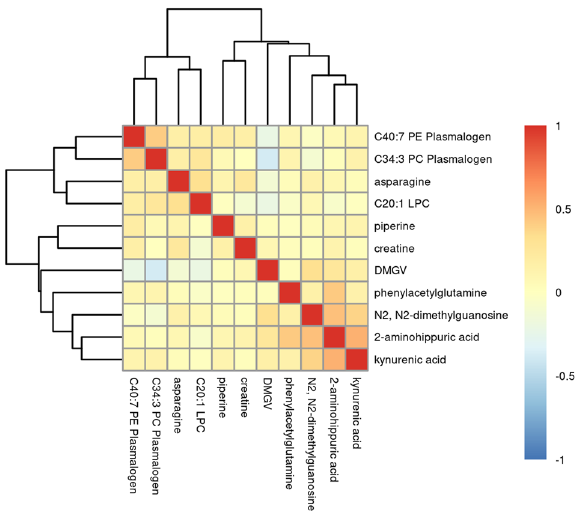
Fig. 2 Heatmap of all pairwise correlations among the 11 metabolites associated with breast cancer risk. Positive correla- tions are shown in shades of red while inverse correlations are shown in shades of